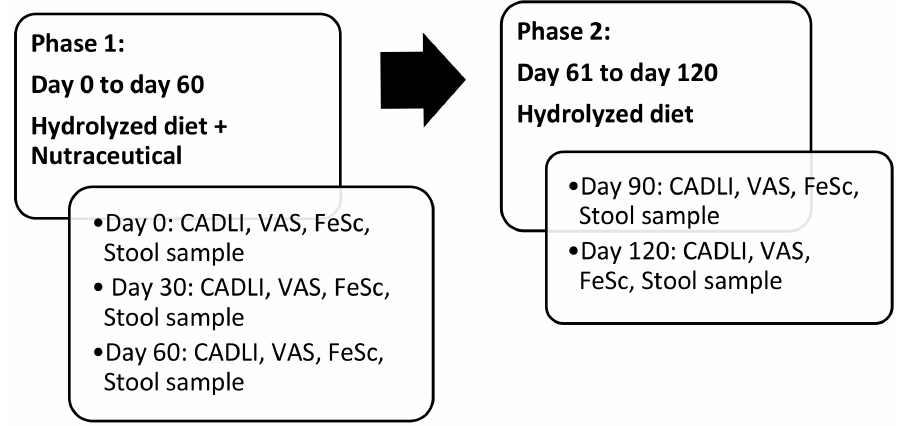
Figure 1. Study design flow